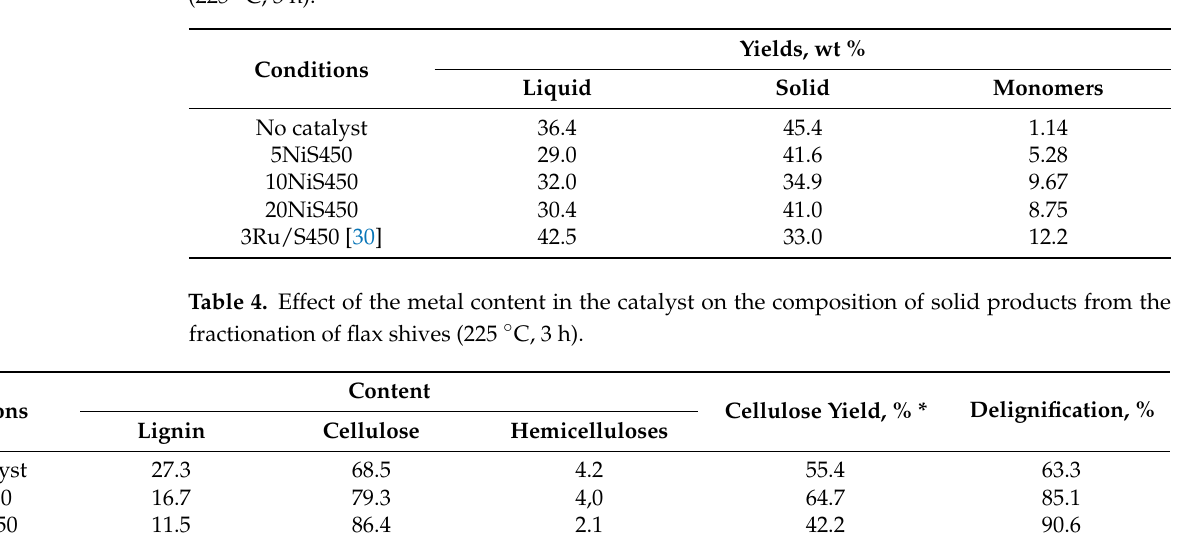
Table 3. Effect of the metal content in a catalyst on the fractionation product yield of flax shives (225 ◦ C, 3 h).